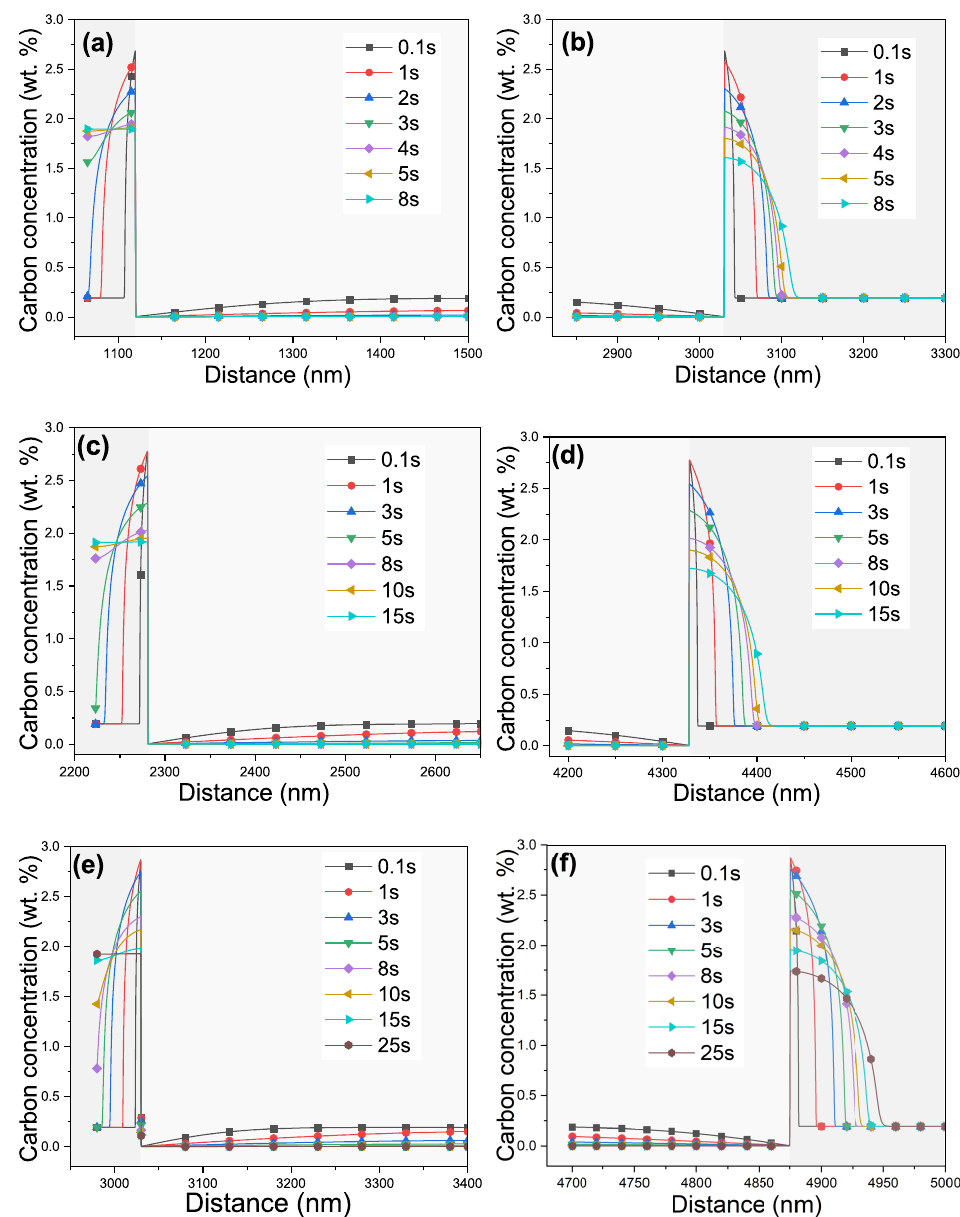
Figure 3. Carbon concentration profiles for the partitioning time ranging from 0.1 s to 25 s at ( a , b ) 330 ◦ C, ( c , d ) 310 ◦ C, and ( e , f ) 292 ◦ C, between ( a , c , e ) film-like austenite and lath martensite, ( b , d , f ) blocky austenite and lath